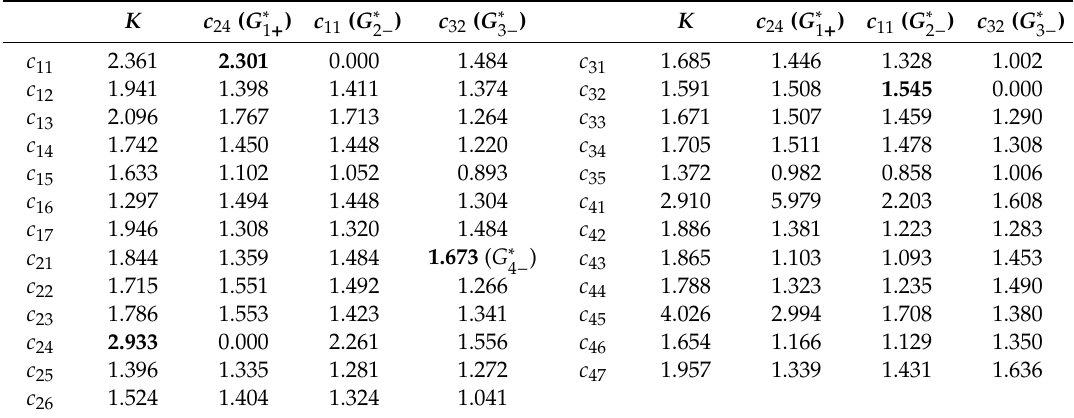
Table 4. The obtained central seed tourist sights and objective function